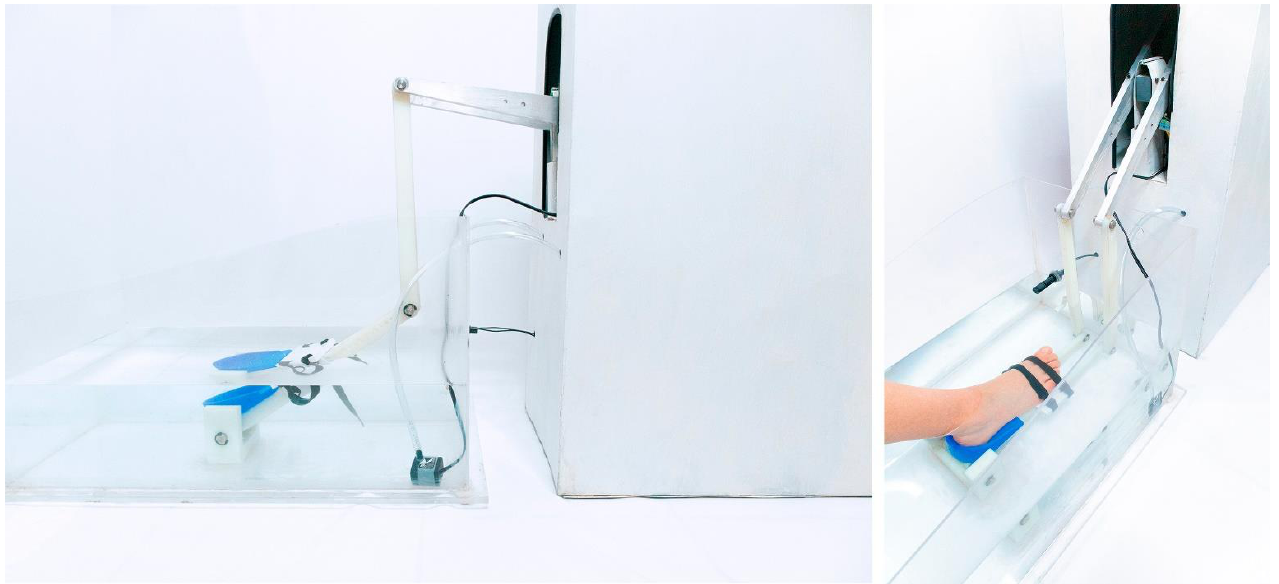
Figure 15. Ankle rehabilitation robot incorporating aquatic therapy.